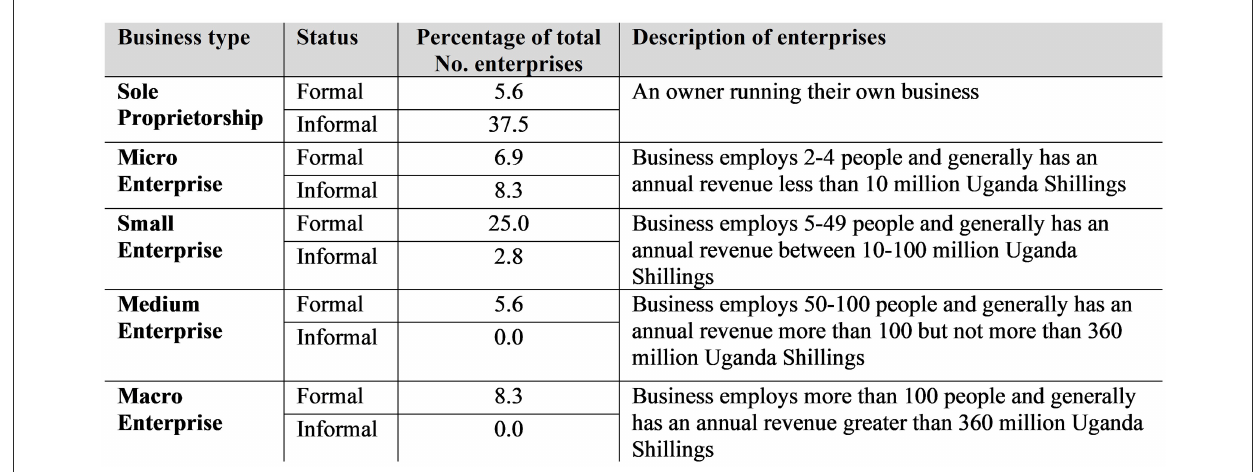
FIGURE3 Categories of CE enterprises